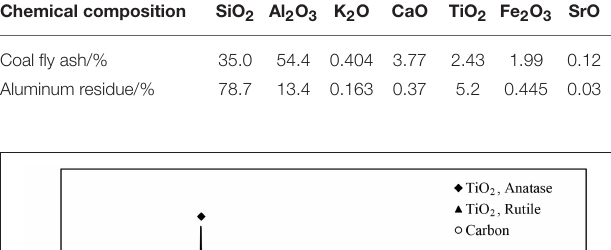
TABLE 1 | Chemical analysis of coal fly ash and aluminum residue. Chemical composition